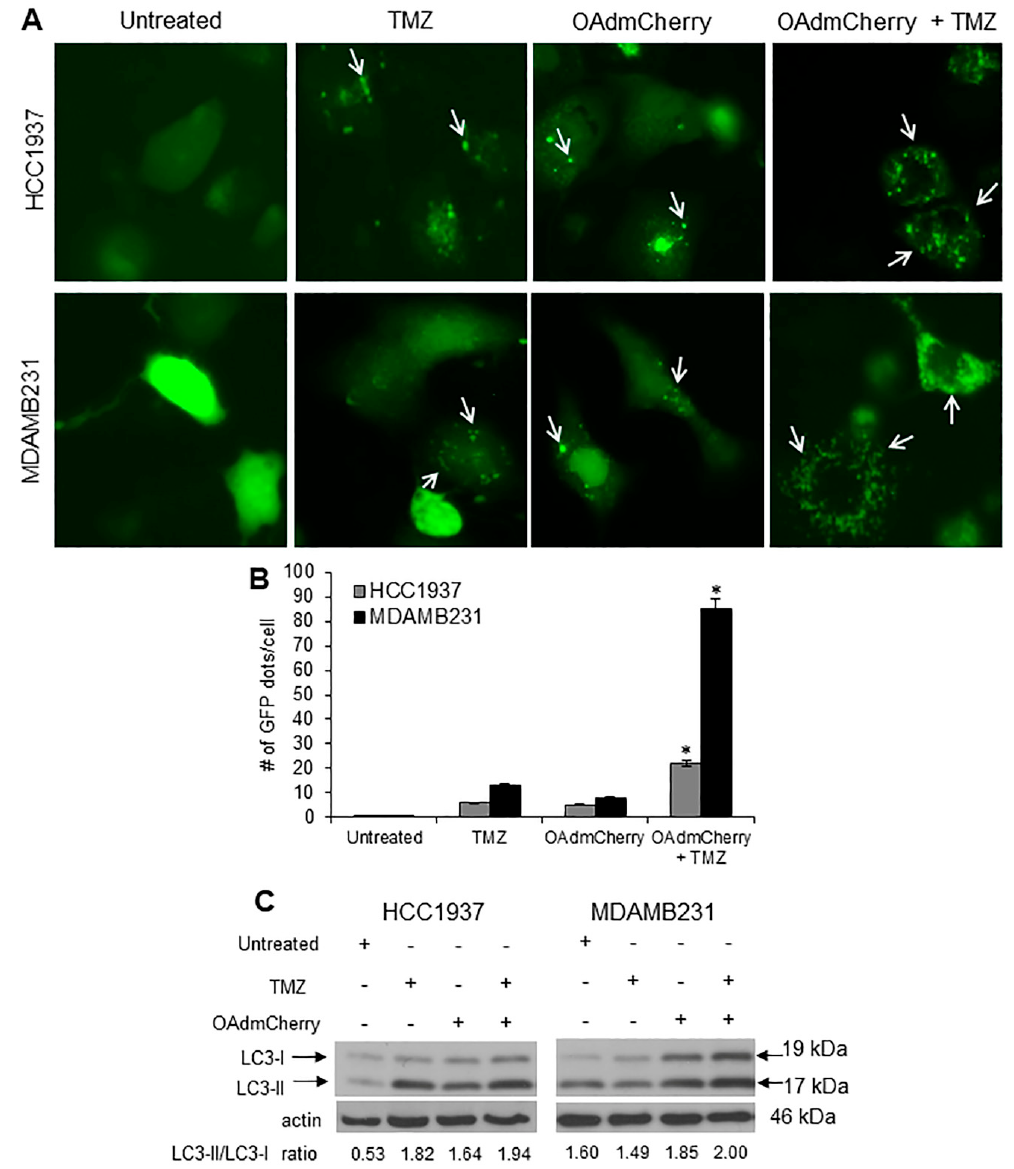
Figure 5. Combined therapy increases autophagosome formation and light chain 3 (LC3)-II accumulation: ( A ) Human triple-negative breast cancer (TNBC) cells were transfected with pEGFP-LC3 followed by treatment with temozolomide (TMZ) at 0.4 mM or oncolytic adenovirus mCherry (OAdmCherry) at a multiplicity of infection concentration of 10 alone or in combination. Integration of GFP-LC3 into the autophagosome is depicted by punctate structures (arrows) and was analyzed by fluorescence microscopy at 48 h post treatment. Images were taken at 40× magnification with the EVOS FL Imaging System (Advanced Microscopy Group) under 357/44 and 447/60 nanometers (nm) excitation and emission visualization, respectively. ( B ) Comparison of number of GFP dots per cell in untreated cells or cells treated with TMZ, OAdmCherry, or a combination of both. A representative experiment is shown from three performed (* p < 0.05). ( C ) Whole cell protein lysates were collected 24 h post treatment. Expression of LC3-I and LC3-II was detected by Western blot analysis; actin was used as a loading control. A representative experiment is shown from three performed.